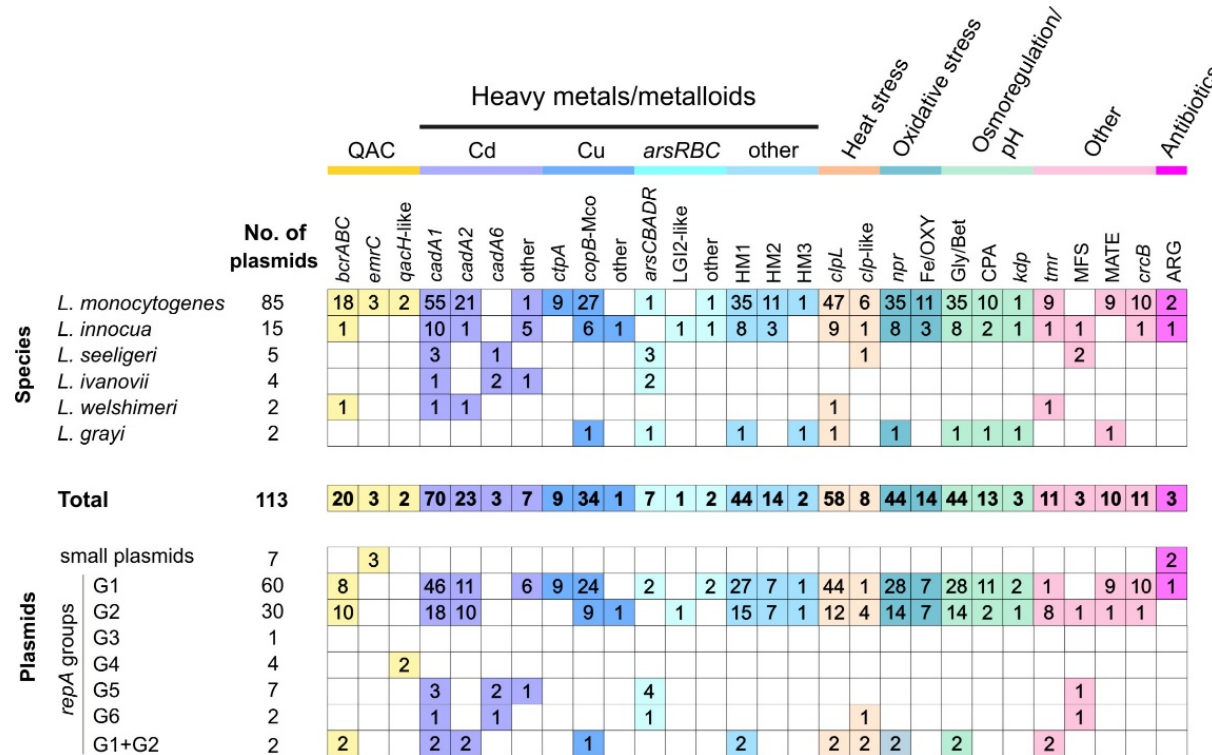
Figure 5. Distribution of selected plasmid-encoded genes potentially involved in stress responses, grouped by Listeria species ( upper panel ) or by plasmid replication system group ( lower panel ). Numbers in boxes represent the number of plasmids harboring specific genes. Abbreviations are as follows: QAC—quaternary ammonium compound, Cd—cadmium, Cu—copper, As—arsenic, LGI2-like—the arsenic resistance operon similar to that in genomic island LGI2, HM1-HM3—heavy metal ATPases, Gly/Bet—glycine/betaine ABC transporter, Fe/OXY—proteins putatively involved in iron export or the oxidative stress response, CPA—cation/proton antiporter, MFS—major facilitator superfamily transporters, MATE—multidrug and toxic compound extrusion family pumps, ARG—antibiotic resistance genes. Frame ‐ shifted genes were included when present.